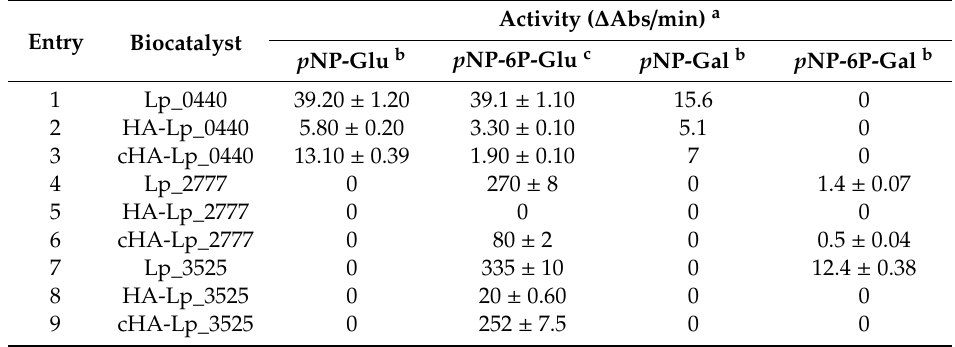
Table 1. The hydrolysis of p- nitrophenyl-glycopyranosides catalyzed by glycosidases from L. plantarum at 25 °C a .